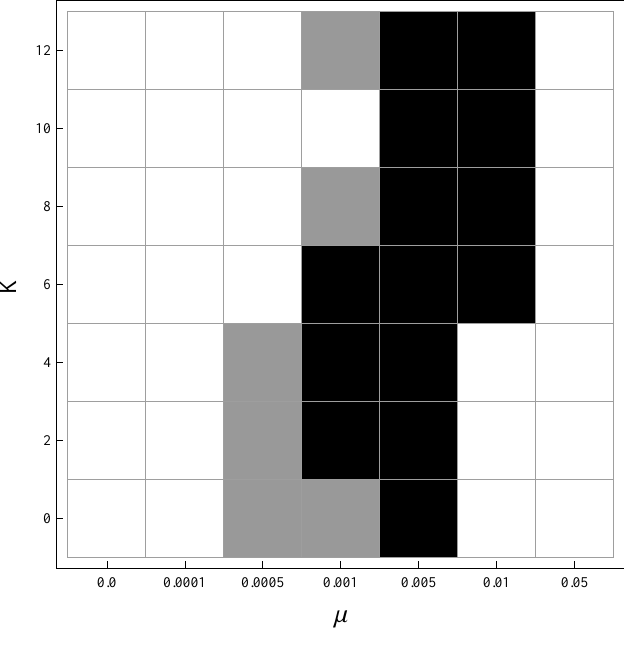
Figure 6. Comparison of PDV between λ = 0 . 2 and λ = 1 . 0 for various degrees of complexity, K , and environmental turbulence, µ . p = 1 . 0 and δ = 0 . 999 , in calculating PDVs. White (black) areas indicate that λ = 1 . 0 ( λ = 0 . 2 ) performs better. Gray areas indicate that there is no difference between λ = 1 . 0 and λ = 0 . 2 .